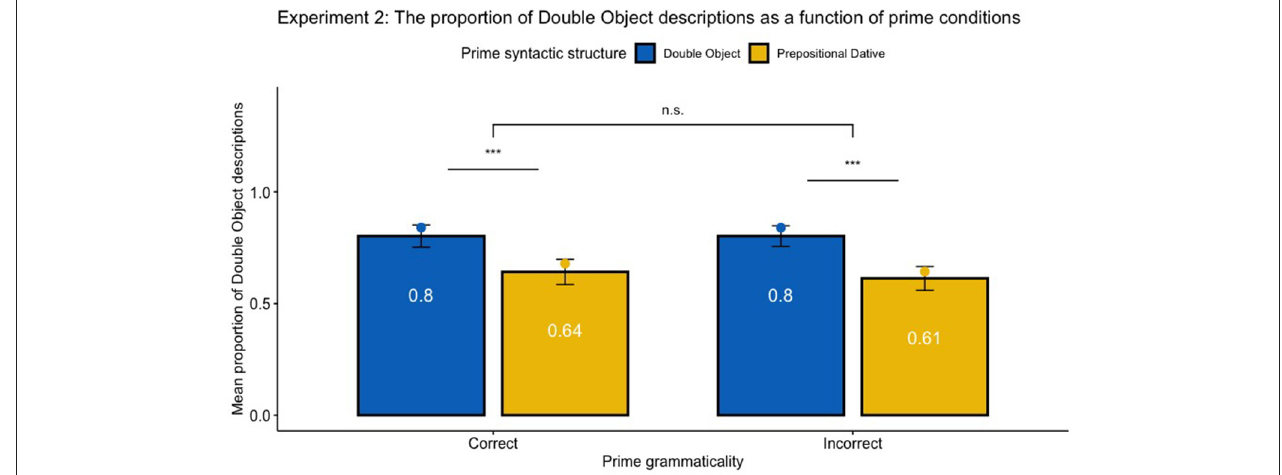
FIGURE 5 | Experiment 2: Mean proportion of producing DO constructions as a function of prime grammaticality (Correct vs. Incorrect) and syntactic structure (DO vs. PD). The bar graph and the numbers within each bar represent the mean proportion of produced descriptions across participants, with error bars representing 95% confidence interval. The dot plot represents the estimated proportion transformed by mixed effect logistic model outputs. Asterisk indicates significance level (*** means p < 0.001, and n.s. indicates non-significant results). No significant effect of grammaticality was found, z = 1.2, p > 0.1. No interaction between Syntactic Structure and Syntactic Correctness was found, z = − 0.76, p > 0.1. Statistical analysis showed significant priming effects, controlling for syntactic correctness, p <